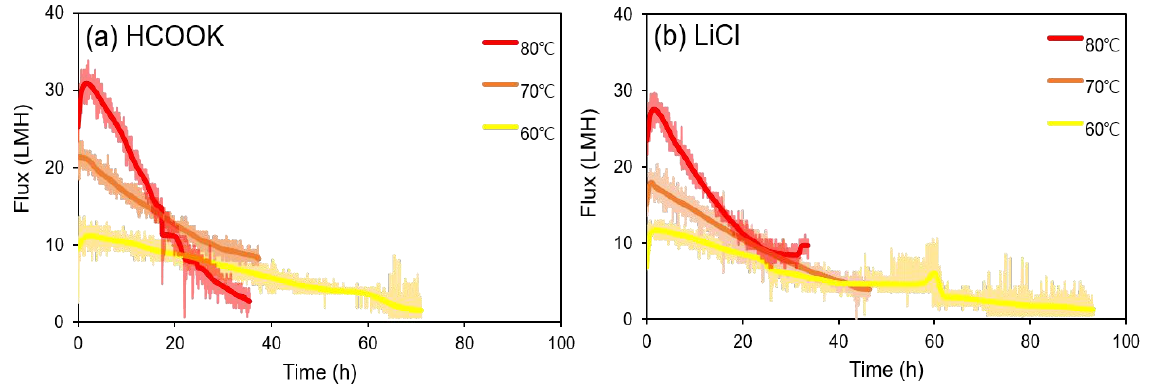
Figure 5. Comparison of flux decline (in terms of concentrating time) depending on the feed tem- perature of ( a ) HCOOK and ( b ) LiCl.